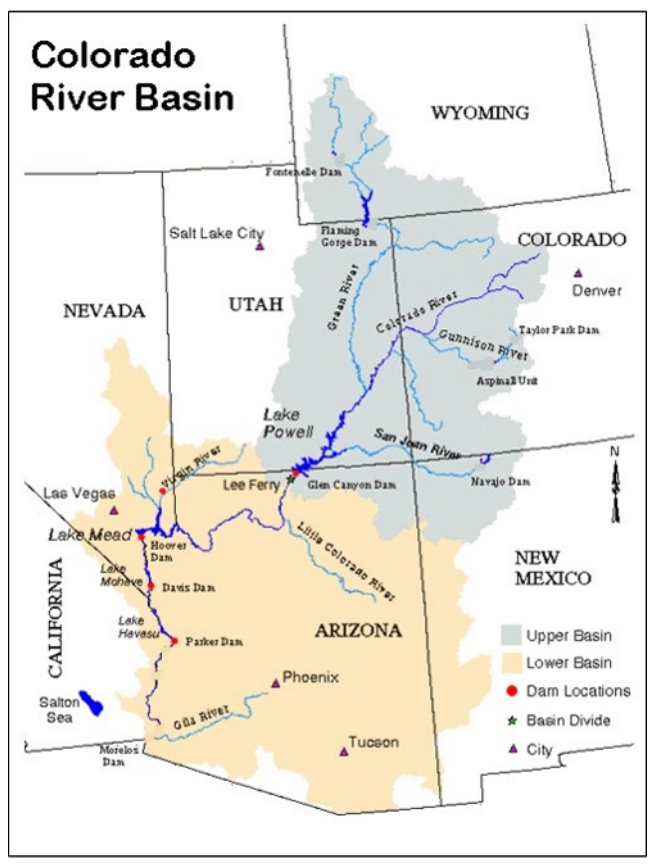
Figure 8. Location of gages at the Colorado River near Lee’s Ferry, Paria River near Lee’s Ferry, Little Colorado River near Cameron, Virgin River near Littlefield, the Colorado River below the Hoover Dam, the Colorado River below Davies Dam, and the Colorado below Parker Dam (red